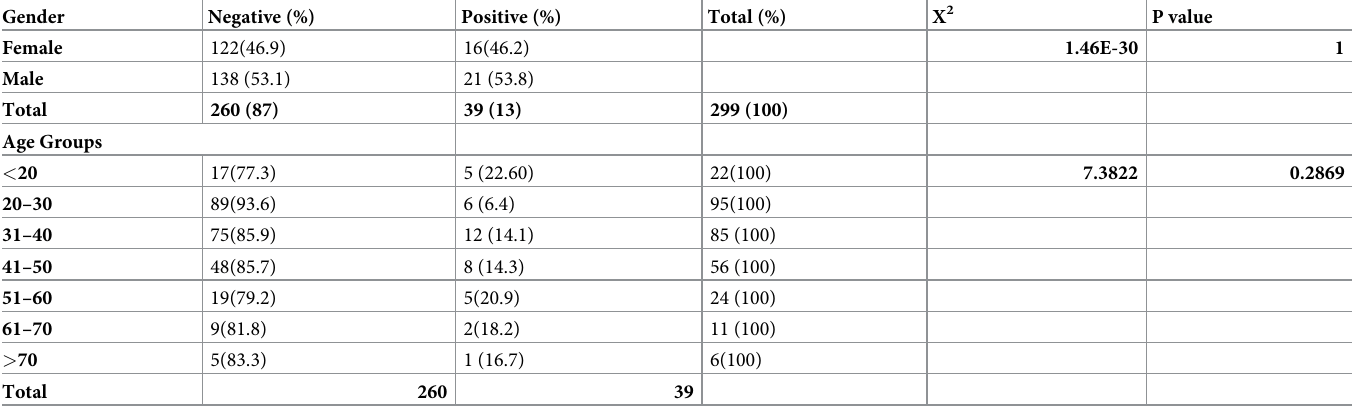
(Table 3). The percentage of positive and negative agreement of the saliva samples as compared with the nasopharyngeal swab were 67% and 97% respectively. The positive and negative pre- dictive values were 69% and 96% respectively. There was no statistically significant relationship observed between the sex/gender of the participants and their COVID-19 RT-PCR nasopharyngeal (p-value = 0.6042) or saliva test results (p-value = 1) using the Pearson’s Chi-Squared test for categorical variables. A strong agreement was observed between the Nasopharyngeal and Saliva methods which were statisti- cally significant [Mean Square Contingency Coefficient (phi coefficient) = 0.64; p-value < 0.01]. However, there was no statistically significant relationship between the age of the par- ticipants and their COVID-19 RT-PCR test positivity by saliva (p-value = 0.1512) and naso- pharyngeal swab (p-value = 0.1066) respectively using the t. test for continuous predictor variables. Comparing the median Cycle Threshold (Ct) values of the three (E, N, and Orf1ab) genes of the positive samples from both the nasopharyngeal swab and saliva samples, shows there were no statistically significant differences between the median E-gene, N-gene, and Orf1ab Ct values detected for SARS-CoV-2 for both sampling methods (Nasopharyngeal swab and Saliva samples) (Fig 1). Table 2. Relationship of SARS-CoV-2 positivity with gender and age groups.